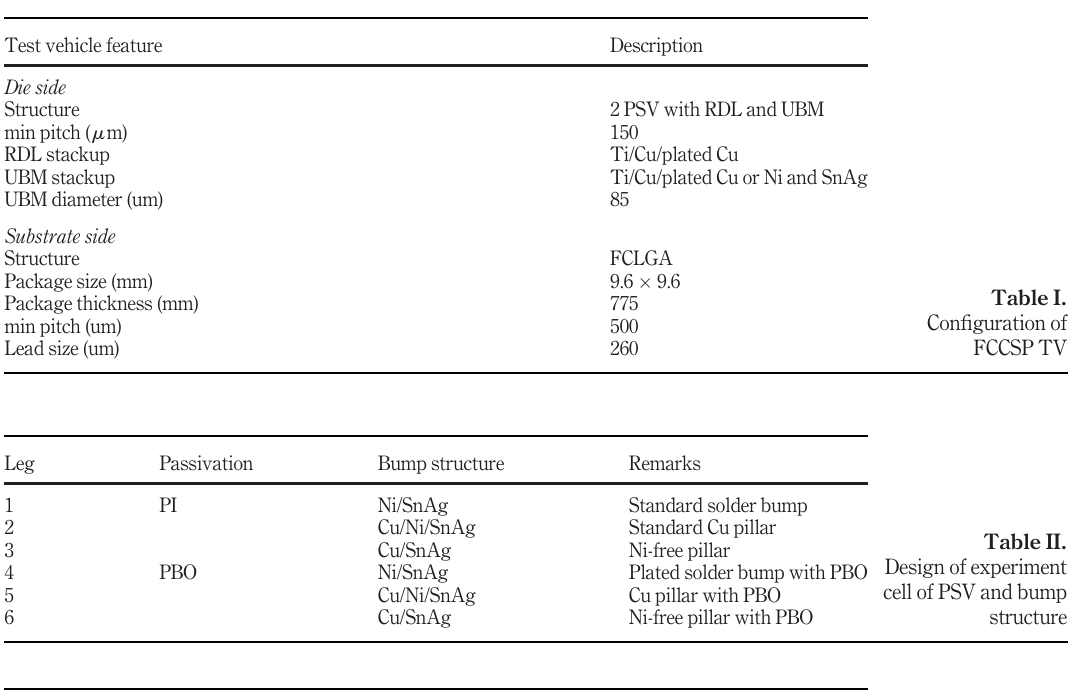
Table III. Reliability testing